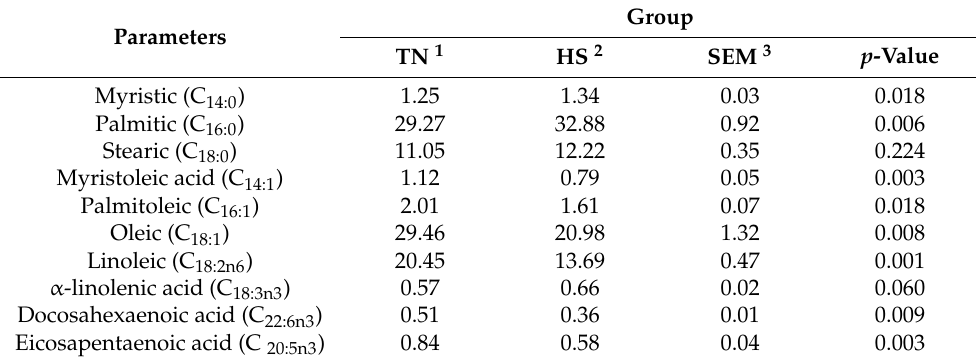
Table 3. Effect of chronic heat stress on fatty acid profile (g/100 g) of thigh muscles in broiler chickens. Parameters